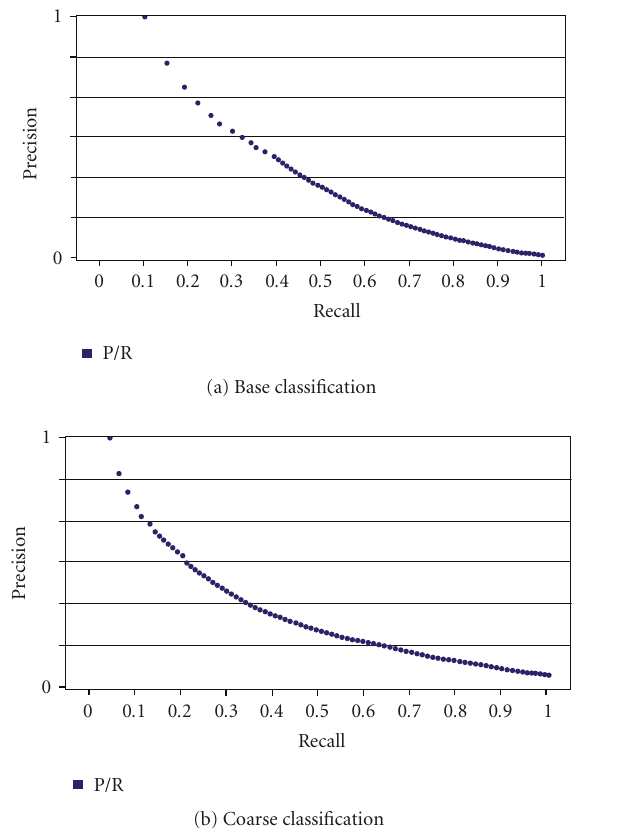
Figure 7: The average precision-recall curves of base and coarse classifications in OMDB2.